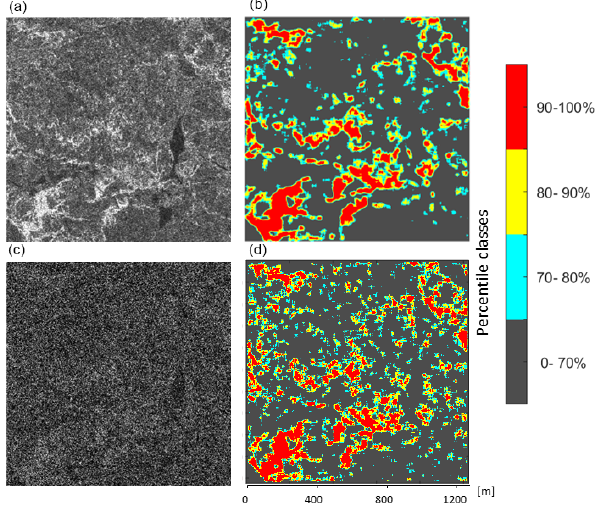
Figure 14. Results for 1024 × 1024 stripmap subimage multiplied 8 times by a random matrix. (a, c) The subimage (a) and the ran- domised subimage (c) . (b, d) Category versions of contextual im- ages obtained by BPP 20% and a 21 × 21 convolution kernel for the original subimage (b) and for the randomised subimage (d)